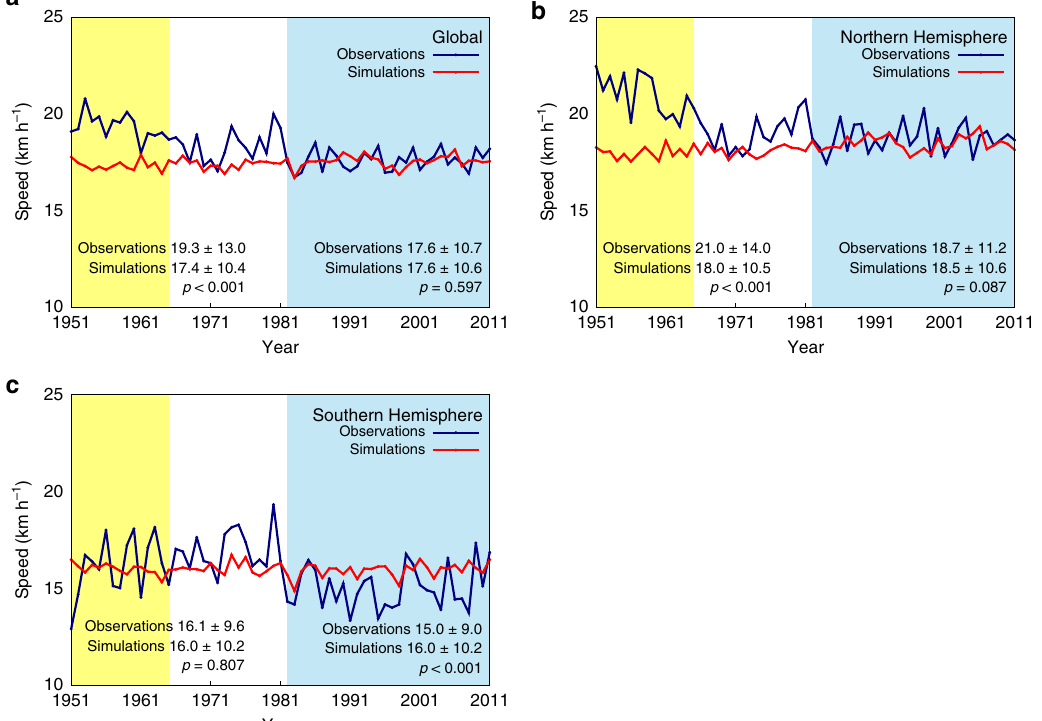
Fig. 1 Global and hemispheric time series of annual-mean tropical cyclone translation speed from the observations and simulations. a – c The period of the time series is 1951 – 2011. Navy blue (red) line is for the observations (simulations). Yellow (blue) shading indicates the pre-satellite (post-geostationary satellite) era. Time series are shown for the global ( a ) data and for the Northern ( b ) and Southern ( c ) Hemisphere data. The period average annual-mean translation speed and one standard deviation in the pre-satellite (post-geostationary satellite) era are shown with p value using the two-tailed Student ’ s t test to assess the statistical signi fi cance of the difference between the observations and simulations in the bottom left (right) corner of each